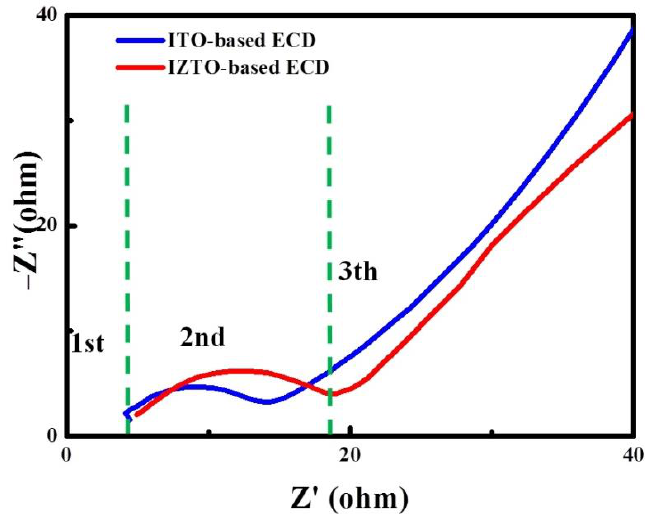
Figure 9. Nyquist plots of IZTO-based and ITO-based ECDs.